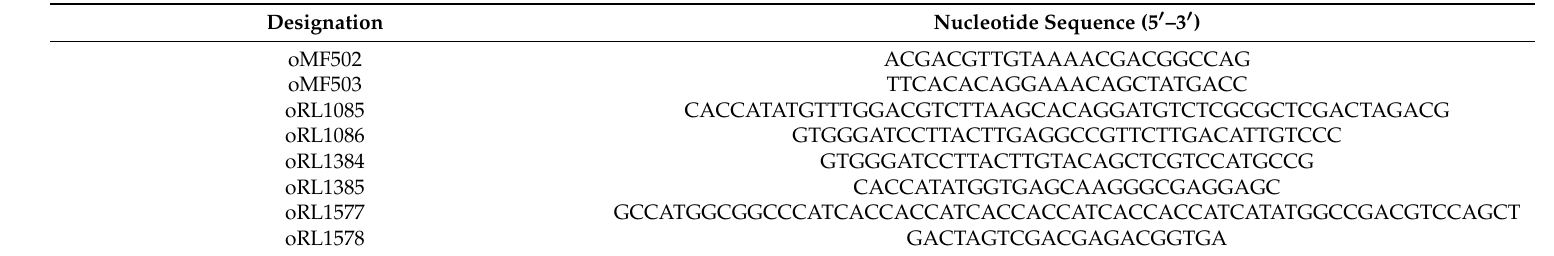
Table 3. DNA oligonucleotides used in this